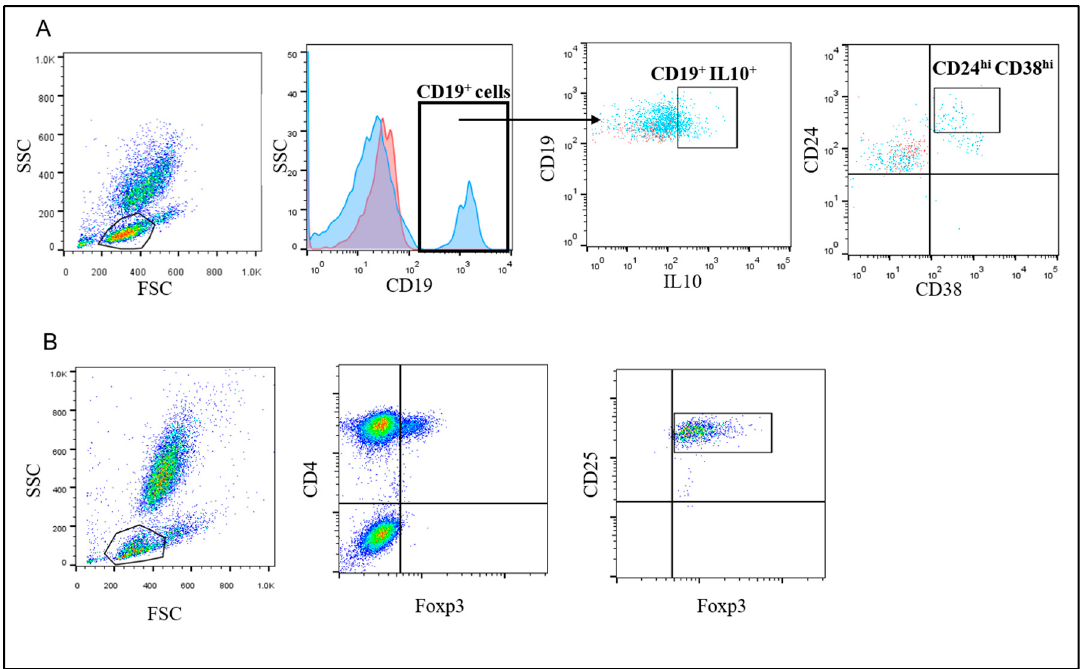
Figure 1. Representative flow cytometry gating strategy to detect Tregs and Bregs. ( A ) FSC and SSC were used to define the lymphocyte population. CD19 + cells were gated (the blue histogram represents cells stained with anti-CD19 Ab and the red curve represent cells stained with isotype-matched control) and IL-10 + cells were defined. Then cells that are CD24 + CD38 high were assessed (Breg cells were defined as CD19 + IL-10 + CD24 +hi CD38 +hi cells. For the proper gating of the IL-10 + and CD24 +hi CD38 +hi cells (shown as light blue in the dot blots), fluorescence minus one controls were employed (shown in red color in the dot blots) ( B ) FSC and SSC were used to define the lymphocytes population followed by gating the CD4 + Foxp3+ cells. Then, the CD25 + cells were determined (T regs were defined as CD4 + FoxP3 + CD25 +high cells).